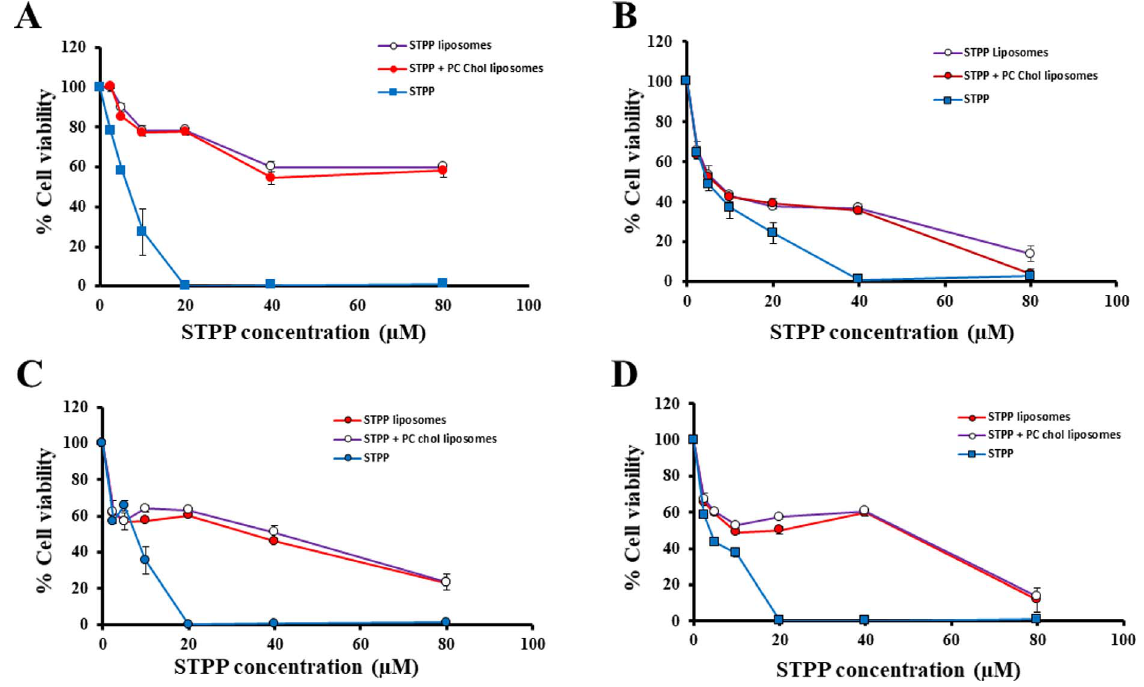
Figure 3. Quantitative determination of STPP toxicity in human lung carcinoma cells. Percent cell viability in A, C : A549 cells and B, D : H69/AR cells, treated with STPP liposomes, STPP in DMSO and STPP in DMSO mixed with PC: Cholesterol liposomes for A, B : 5 h and C, D : 12 h at indicated concentrations of STPP. Values represent mean ± standard deviation from three independent experiments.